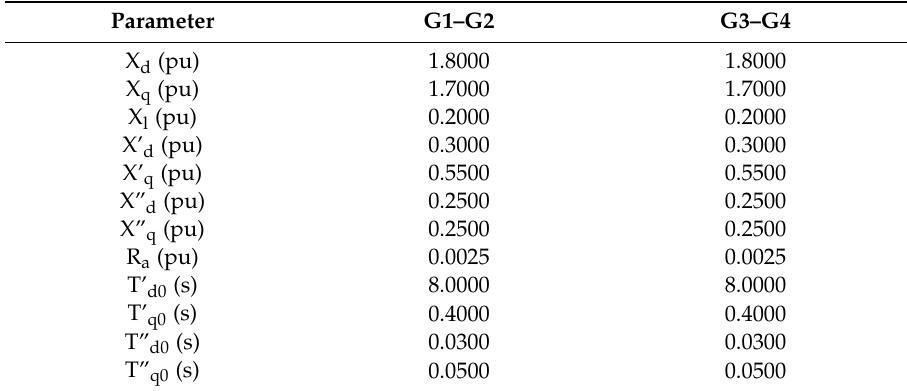
Table 1. Operating parameters of synchronous generator.